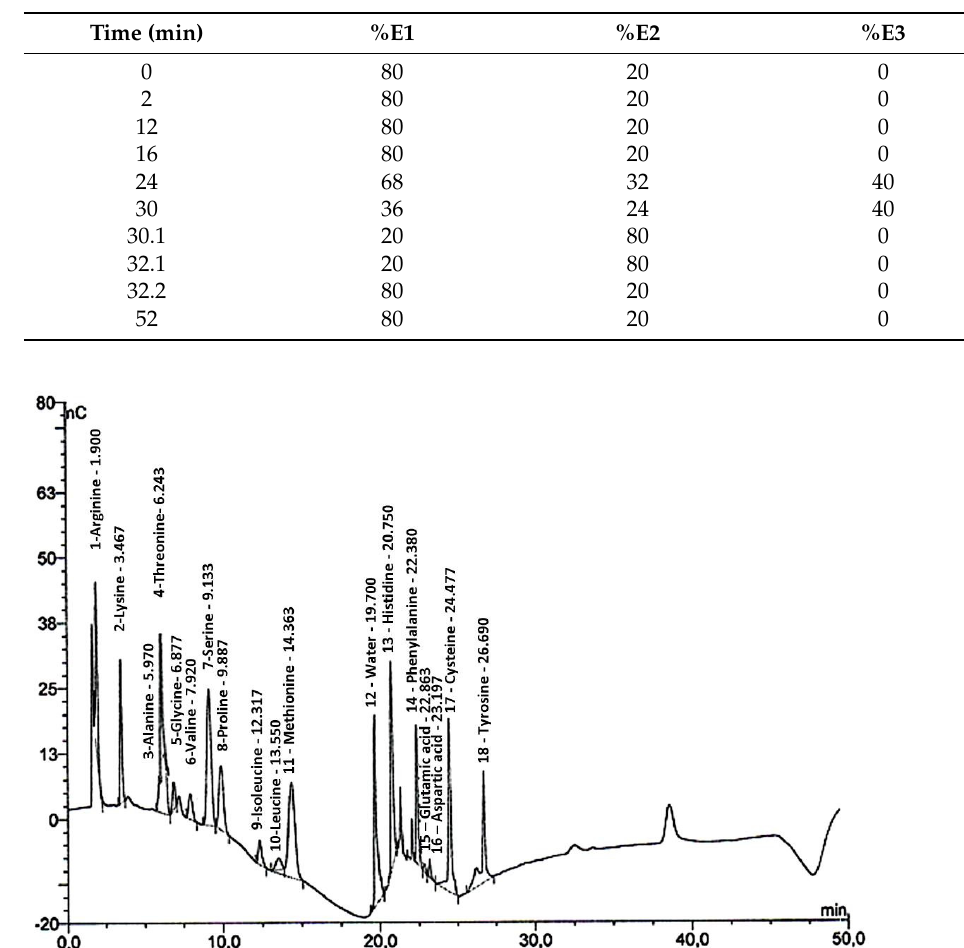
Table 2. Gradient conditions for AA determination.